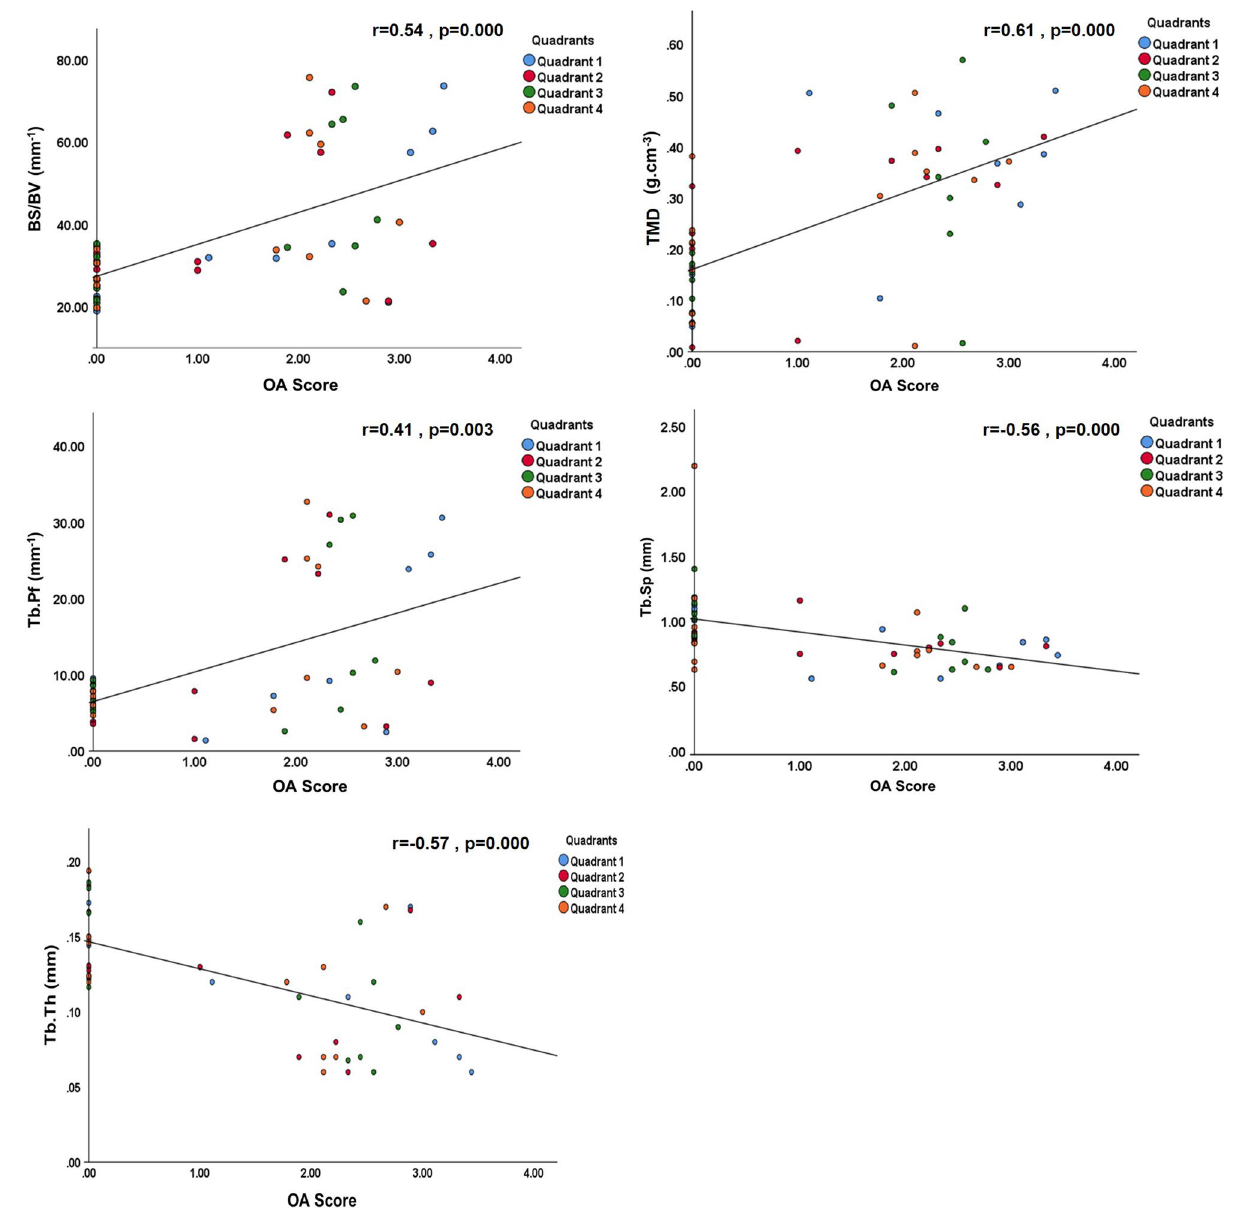
Figure 2. Trabecular bone correlation with OA severity in the entire femoral head. Positive correlation between OA severity and trabecular bone-specific surface (BS/BV), pattern factor (Tb.Pf), tissue mineral density (TMD). Negative correlation between OA severity and trabecular separation (Tb.Sp) and thickness (Tb.Th). P values and Spearman correlation coefficients are indicated on figures. p < 0.01 was considered